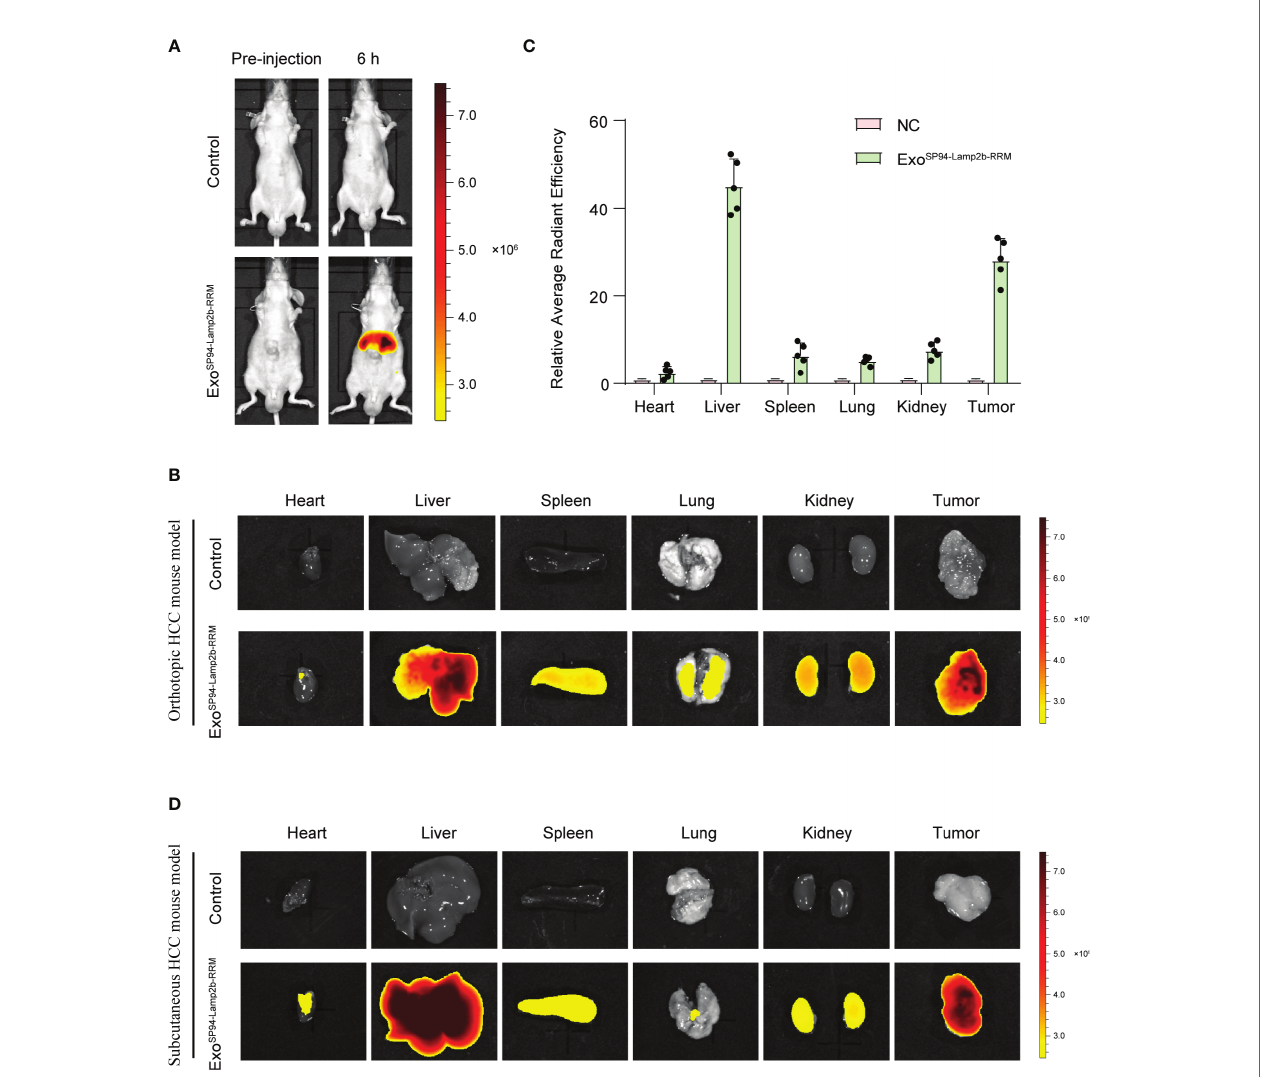
FIGURE 6 | SP94-Lamp2b-RRM-functionalized exosomes could ef fi ciently target HCC in vivo. ( A – C ) Sorafenib-resistant HepG-2 cells were orthotopically inoculated into the left liver lobes of nude mice. SP94-Lamp2b-RRM-functionalized exosomes (100 m g) were injected into nude mice via tail vein. (A) Mice were evaluated with a fl uorescent live imaging system 6 h after injection. (B) Representative ex vivo fl uorescence images of DiR-labeled exosomes in the main organs and HCC tissues. (C) Relative fl uorescence intensity of DiR-labeled exosomes in different organs and liver cancer tissues. (D) Sorafenib-resistant HepG-2 cells were subcutaneously inoculated on the left backs of mice. SP94-Lamp2b-RRM-functionalized exosomes were loaded with DiR, and 100 m g of exosomes was injected into mice via tail vein. Different organs and tumors were harvested to conduct fl uorescence imaging. (C) The data are shown as the means ± S.E. M;